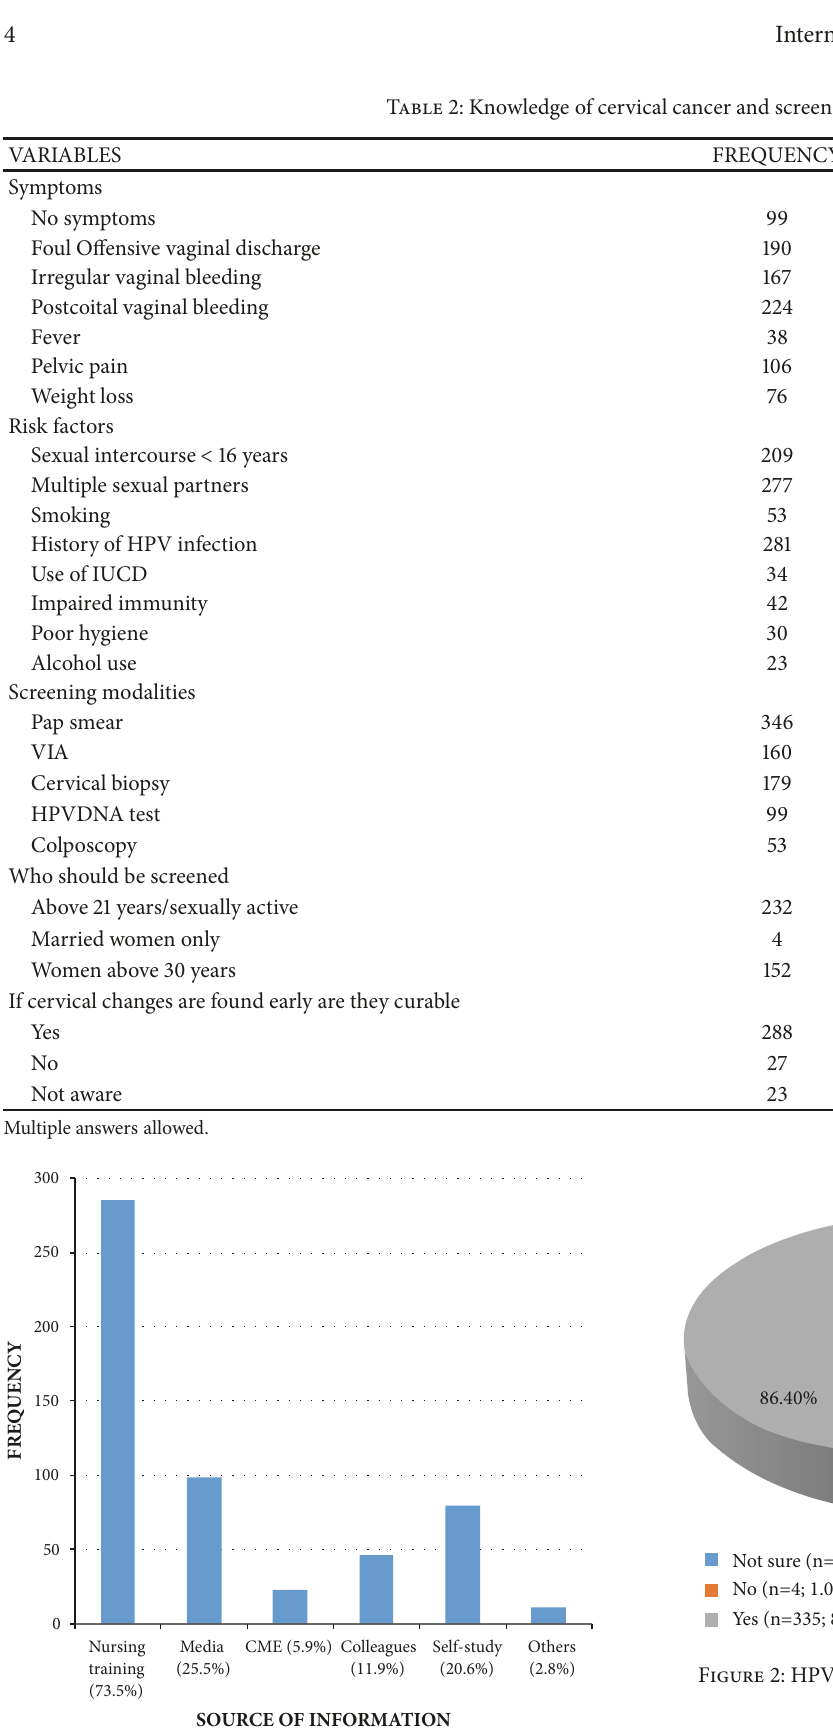
Figure 1: Nurses’ sources of cervical cancer information. CME: continuing medical education.